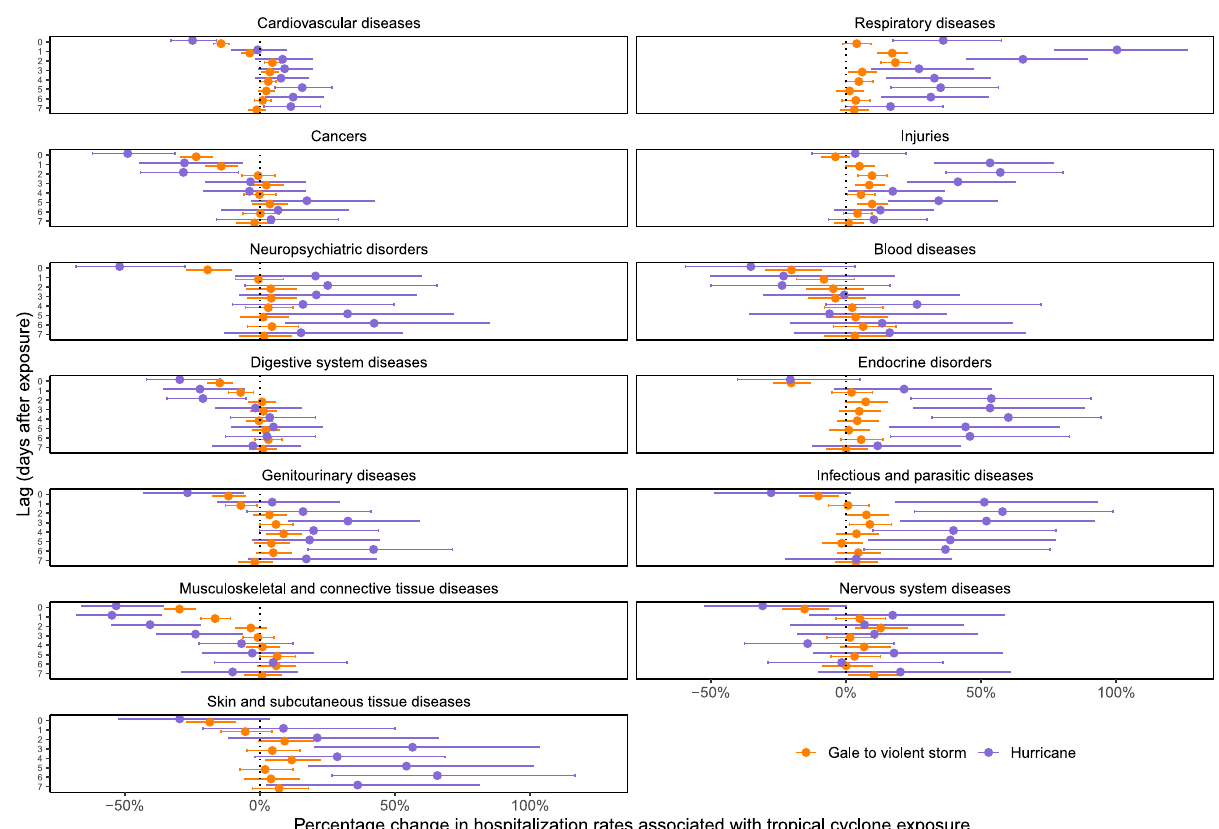
Fig. 5 Percentage change in hospitalization rates with tropical cyclone exposure by cause of hospitalization, intensity of local wind exposure, and lag time. Lag time is measured in days after tropical cyclone exposure. Dots show the point estimates and error bars represent Bonferroni-corrected 95% con fi dence